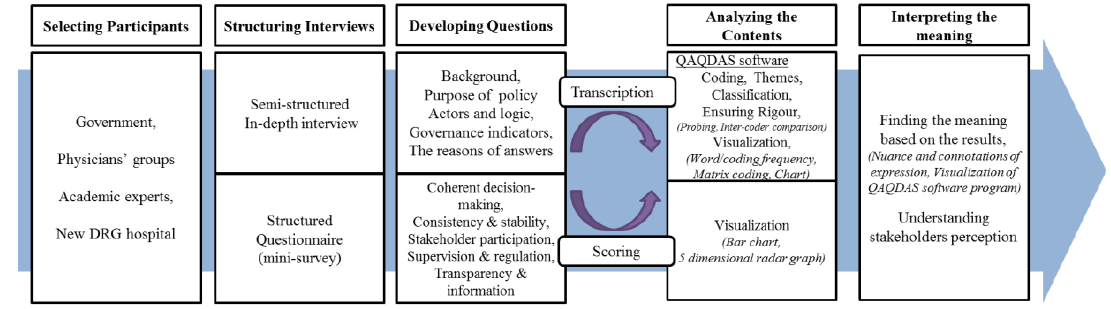
Figure 1. Research process steps: An evaluation of the perception of governance.